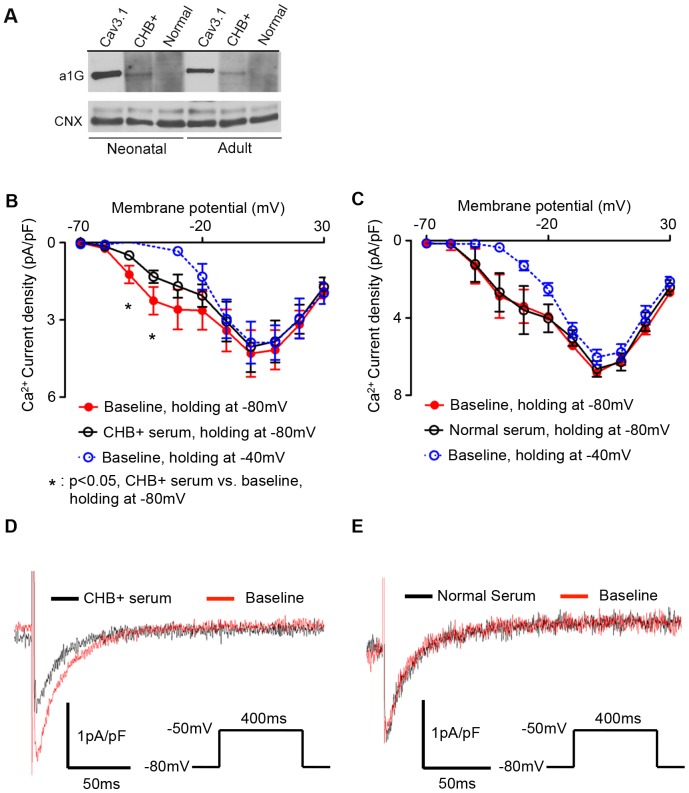
Effect of maternal sera on calcium current in mouse sinoatrial node (SAN) cells.(A) CHB maternal serum antibodies, but not healthy control serum, show reactivity to mouse α1G in Western blot. Commercial α1G (Cav3.1) antibody demonstrates the α1G positive band and calnexin (CNX) antibody probing shows equal loading of mouse heart lysate. (B) Calcium current density-voltage curve with CHB serum, (C) Calcium current density-voltage curve with normal serum, (D) representative Calcium current traces recording at −50 mV from holding at −80 mV with CHB serum, (E) representative Calcium current traces recording at −50 mV from holding at −80 mV with normal serum. CHB serum is defined as an anti-Ro/La positive serum from a pregnancy affected by third-degree AVB or CHB. Normal serum was obtained from a mother with a pregnancy unaffected by CHB, resulting in a healthy outcome.